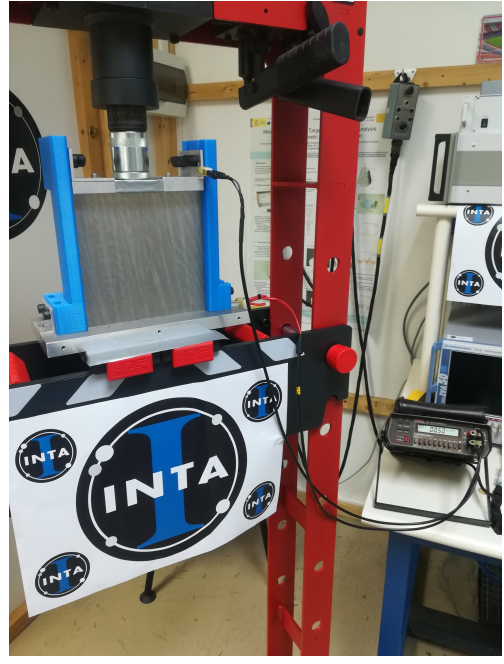
Figure 16. DC square resistance test